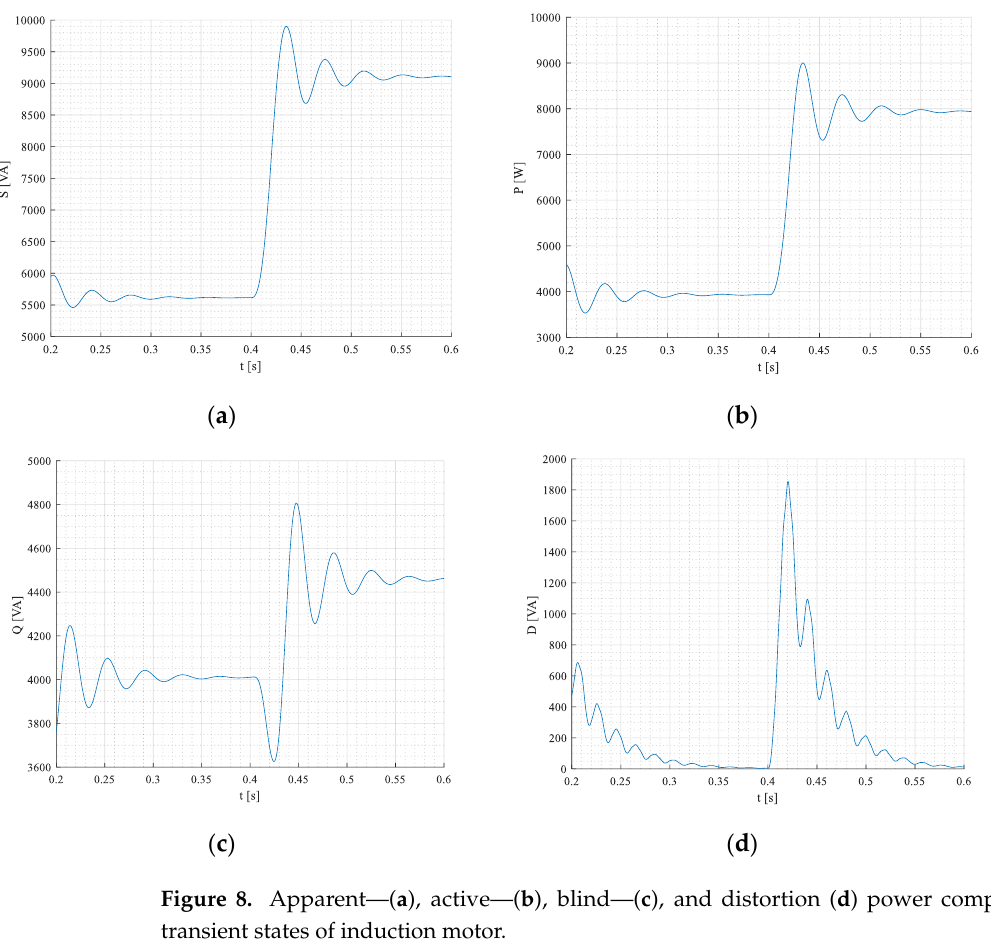
Figure 8. Apparent — ( a ), active — ( b ), blind — ( c ), and distortion ( d ) power components during tran- Figure 8. Apparent—( a ), active—( b ), blind—( c ), and distortion ( d ) power components during sient states of induction motor. transient states of induction motor.